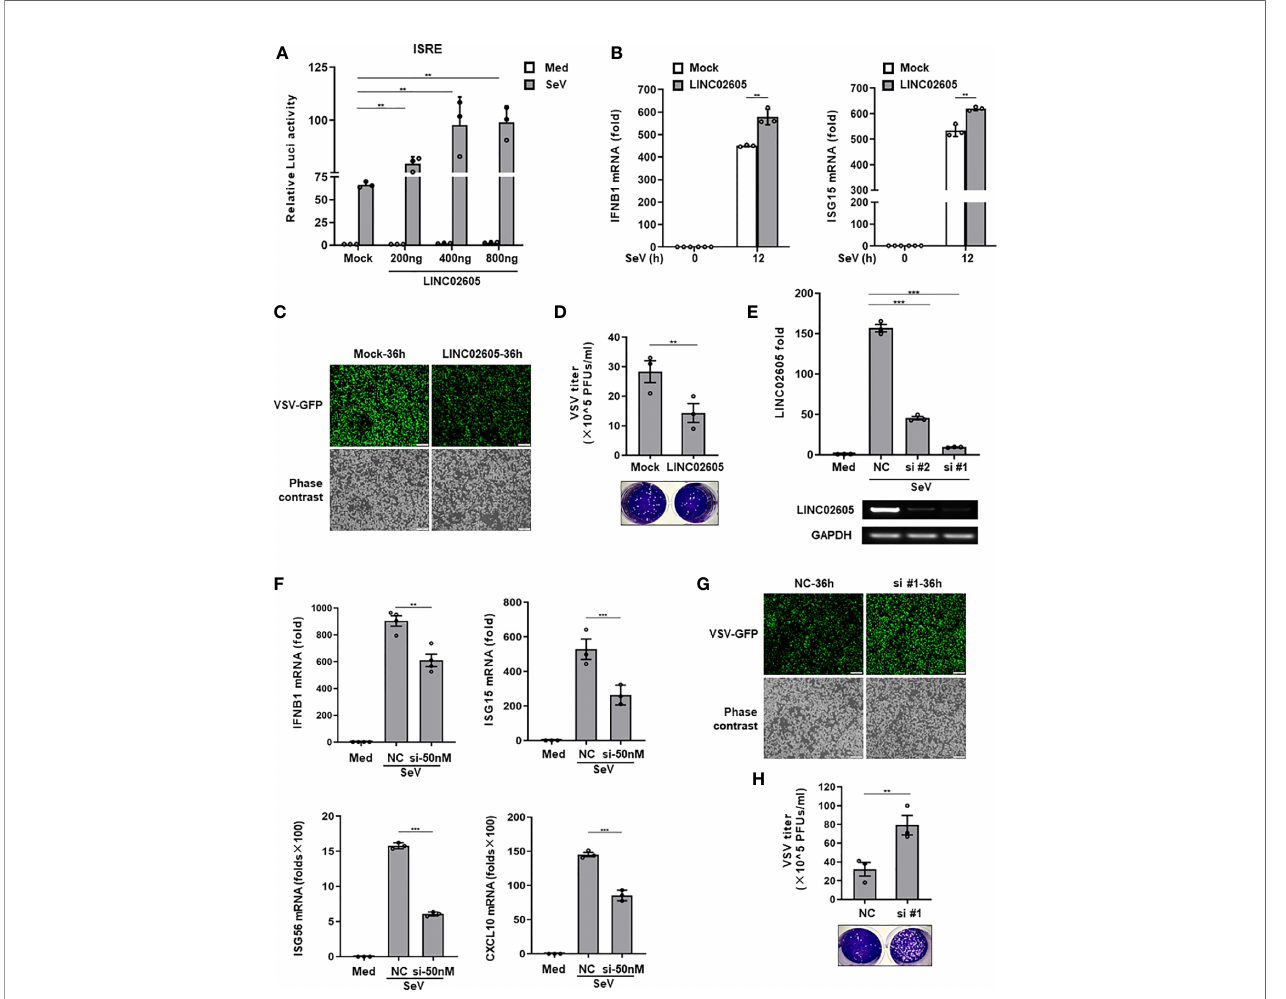
FIGURE 2 | LINC02605 enhances I-IFNs production in response to viral infection. (A) Dual luciferase analysis of ISRE promoter activation in HEK293T cells, after co- transfecting plasmids expressing LINC02605 with indicated does (or empty vector control), an ISRE reporter and pRL-SV40 for 24h, then infected with SeV for 12h. (B) Q-PCR analysis of IFNB1 and ISG15 mRNA expression in LINC02605 expressing vector or empty vector control (mock) transfected HEK293T cells upon SeV infection for 12h. (C) Fluorescence analysis of VSV replication in HEK293T cells transfected by LINC02605 or mock vector which were infected with VSV-GFP for the indicated hours. Scale bar, 1mm. (D) THP-1 cells expressing LINC02605 or its control group were infected with VSV, and the virus titers in culture supernatants were determined through plaque forming assay. (E) Q-PCR analysis of LINC02605 silencing ef fi ciency by two individual siRNA oligos (#1, #2). NC, a